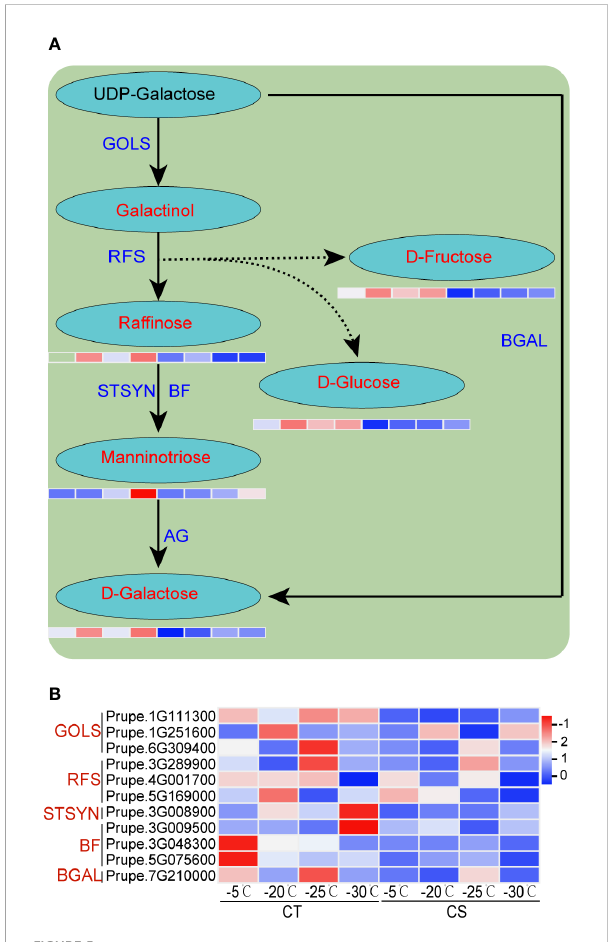
FIGURE 5 Integrated analysis of transcriptome pro fi les and metabolites of peach under cold stress. (A) The schematic diagrams of galactose metabolism pathway. Metabolites and structural enzymes are indicated in red and blue, respectively. The left and right four parts of the rectangles under the metabolites represented the expression levels of DEGs/DEMs in CT and CS, respectively. (B) Heat map of genes encoding the structural enzymes involved in the galactose biosynthetic pathways. Scaled values of FPKM were